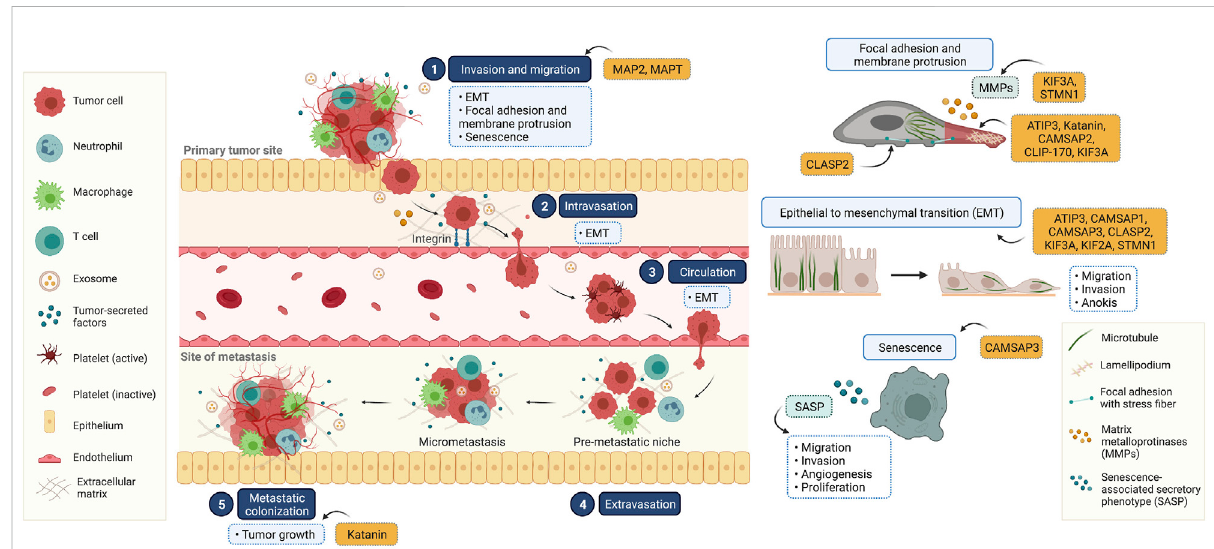
FIGURE 2 Illustratedoverviewofthetumormetastaticprocessandtheparticipationofmicrotubule-associatedproteins(MAPs)inthisprocess.(1)Invasion and migration: cancer cells invade and migrate through the basement membrane and tumor stroma, respectively. This process is involved in epithelialto mesenchymaltransition (EMT),focaladhesionand membraneprotrusion,and senescence. (2) Intravasation: tumor cellscollide withthe endothelial membrane and attach fi rmly via integrin (cell-to-cell adhesion molecules). Subsequently, cancer cells intravasate into the surrounding vasculature or lymphatic system. (3) Circulation: circulating tumor cells survive in the circulating blood and have the ability to evade the immune clearance system. (4) Extravasation: once cancer cells reach their secondary targets, they enter through the endothelial barrier and form a premetastatic niche for tumor cell growth and survival. (5) Colonization: the premetastatic niches recruit several tumor-secreted factors, and the extracellular matrix is remodulated at these sites in a phenomenon known as micrometastasis. In the fi nal step, micrometastasis achieves colonization at the distant organ and secondary tumors are established. This diagram was created with “ Biorender.com ”